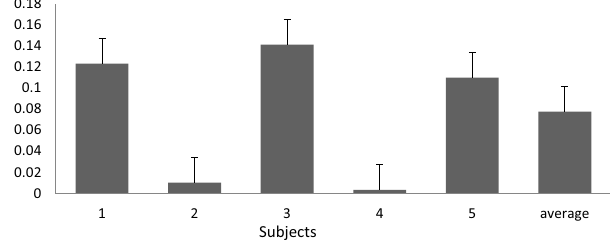
Fig. 8. Average mean square value (%) with SD for the four upper arm movements.